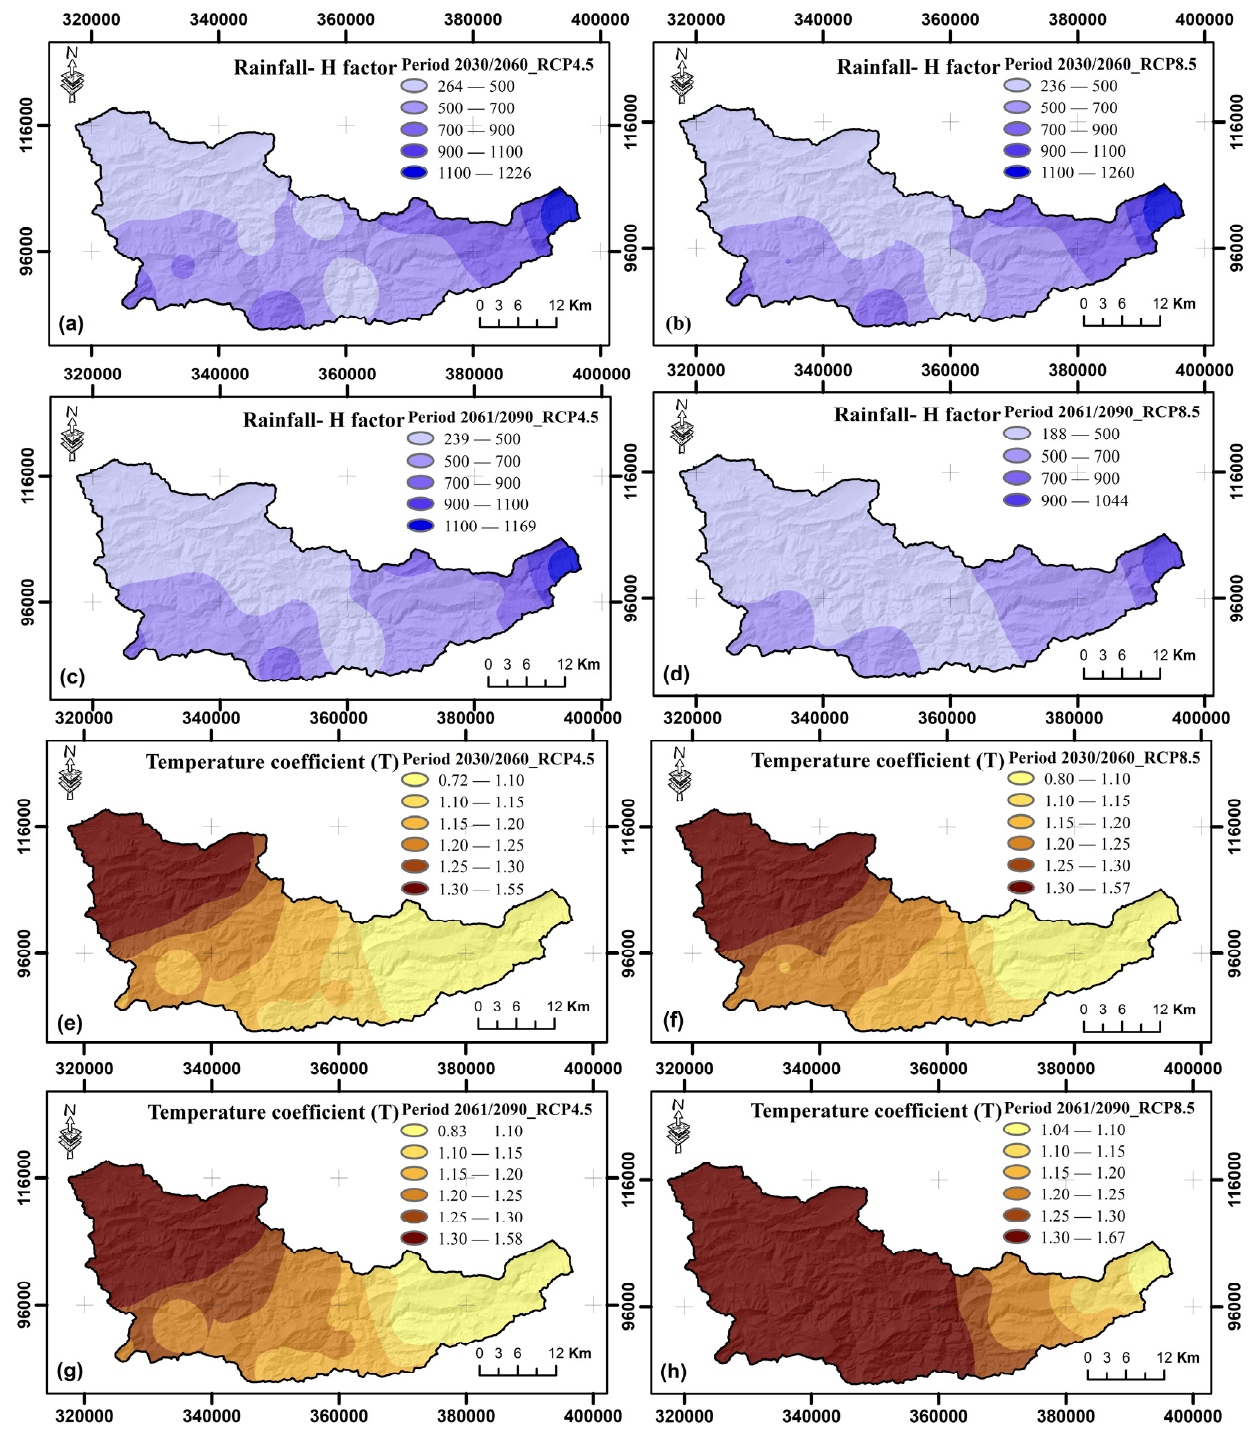
Figure 9. Maps of average annual precipitation (Rainfall-H factor) and temperature coefficient (T) considering future scenarios RCP 4.5 and RCP 8.5. ( a ) period 2030–2060 RCP4.5, ( b ) period 2030–2060 RCP8.5, ( c ) period 2061–2090 RCP4.5, ( d ) period 2061–2090 RCP8.5, ( e ) period 2030–2060 RCP4.5, ( f ) period 2030–2060 RCP8.5, ( g ) period 2061–2090 RCP4.5, ( h ) period 2061–2090 RCP4.5.